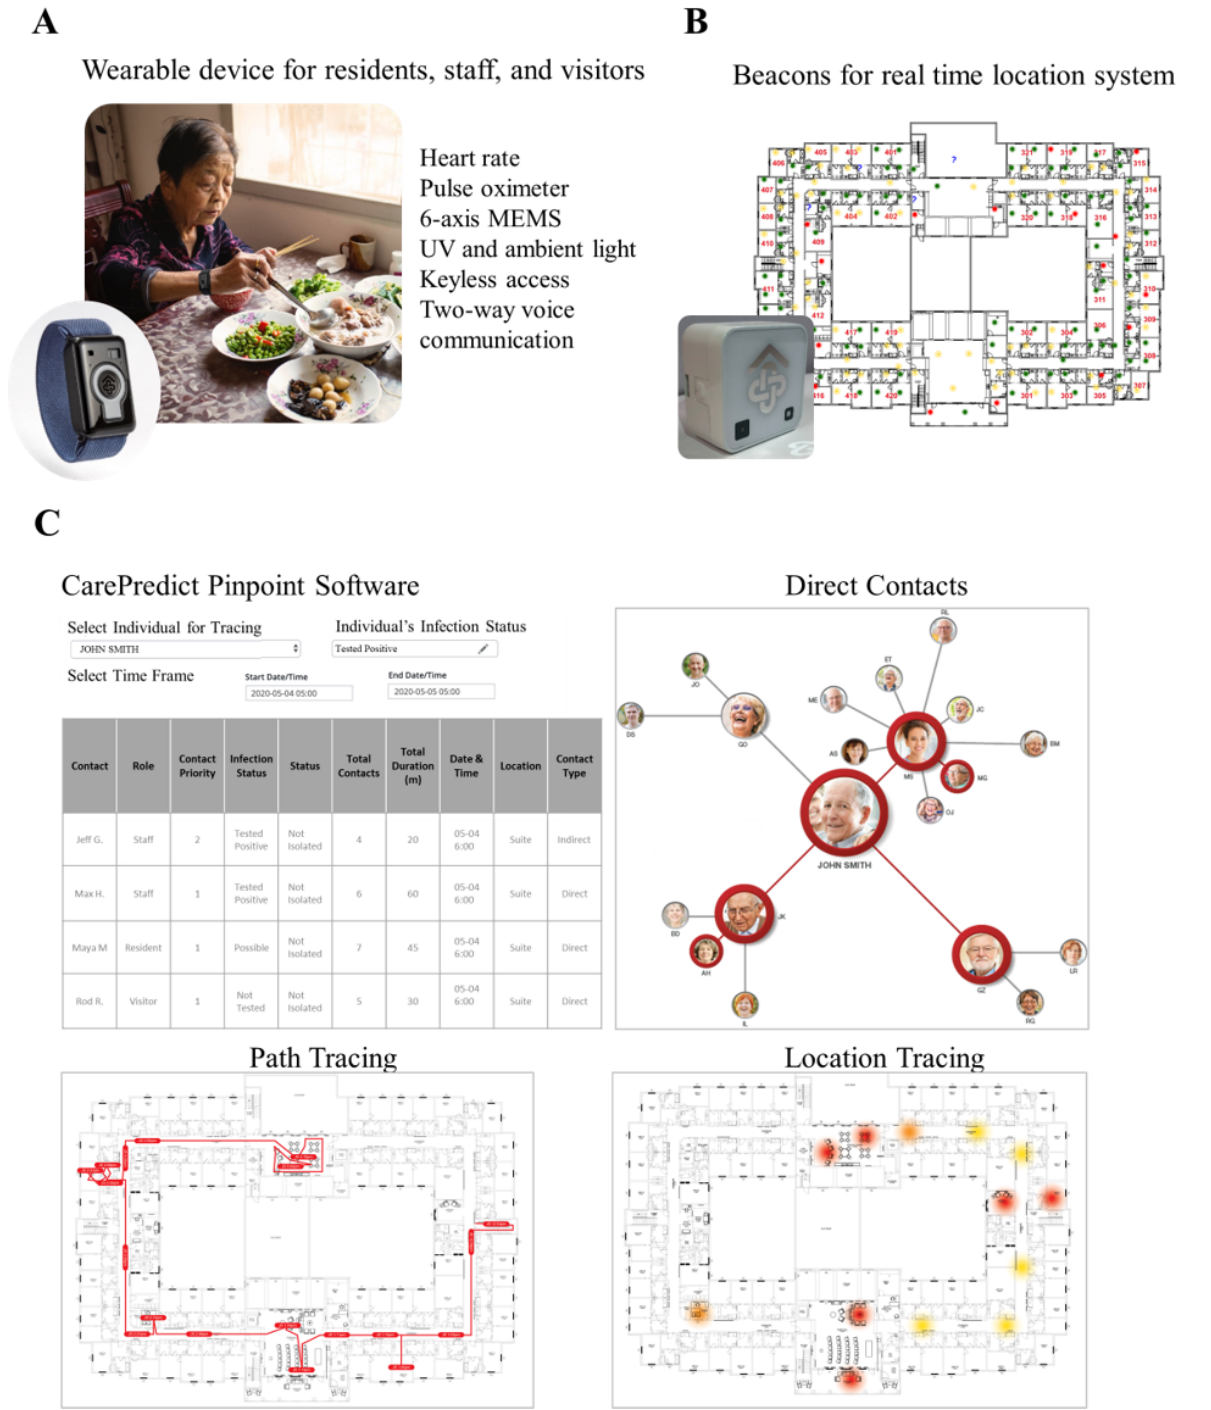
Figure 2. Digital contact tracing system: wearable device, real-time location tracking, and software. A: wearable device; B: real-time location